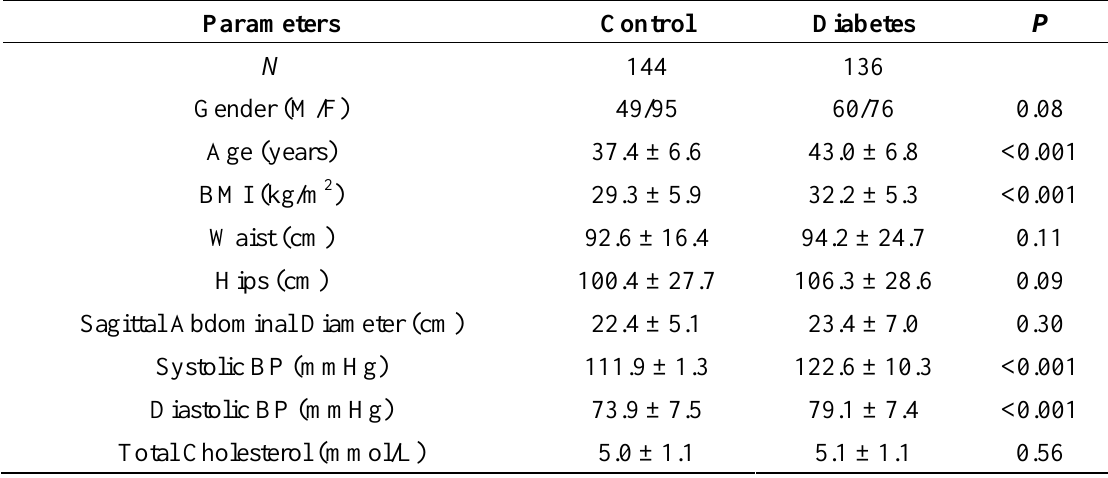
Table 1. Main characteristics of the study subjects according to